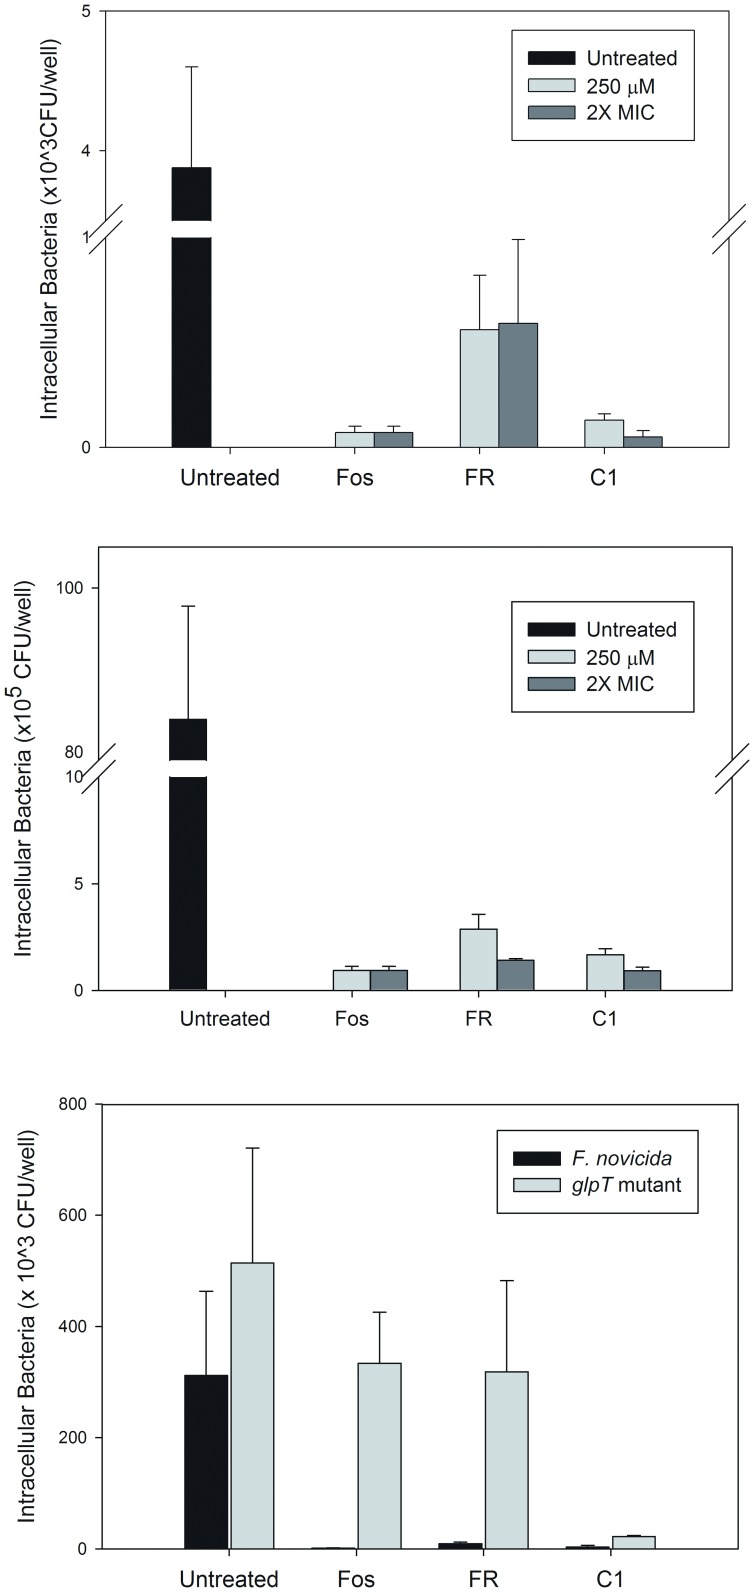
Inhibition of intracellular F. novicida replication in two cell lines following treatment with selected compounds.Cell lines were first infected with F. novicida at an MOI of 500. The cells were treated with the following concentrations of antibiotics. The cells were lysed after 20 hours of treatment and the intracellular bacteria were enumerated. A) Inhibition of intracellular
F. novicida
 in A549 cells with fosmidomycin (Fos), FR900098 (FR), or compound 1 (C1) for 20 hours. Each compound was tested at 250 µM and at 2× MIC (2× MIC for fosmidomycin = 250 µM, 2× MIC for FR900098 = 500 µM and 2× MIC for compound 1 = 400 µM). All three compounds significantly inhibited intracellular F. novicida growth. At 250 µM, intracellular growth was inhibited 98.0±0.7% by fosmidomycin, 86±6% by FR900098, and 97.0±0.8% by compound 1. At 2× MIC, FR900098 (500 µM) inhibited 85±10% of intracellular growth, while compound 1 inhibited 99.0±0.7% of intracellular growth. B) Inhibition of
F. novicida
 in RAW264.7 cells with fosmidomycin, FR900098, and compound 1 for 20 hours. Similar results were seen for the RAW264.7 cells as were seen for the A549 cells. C) Inhibition of the
F. novicida glpT
 mutant intracellular replication in A549 cells. The intracellular-replication inhibition experiment was performed using the glpT mutant as previously described for wild-type F. novicida. Replication of intracellular glpT mutant was not affected by fosmidomycin (250 µM) and FR900098 (500 µM), but was susceptible to compound 1 (400 µM).